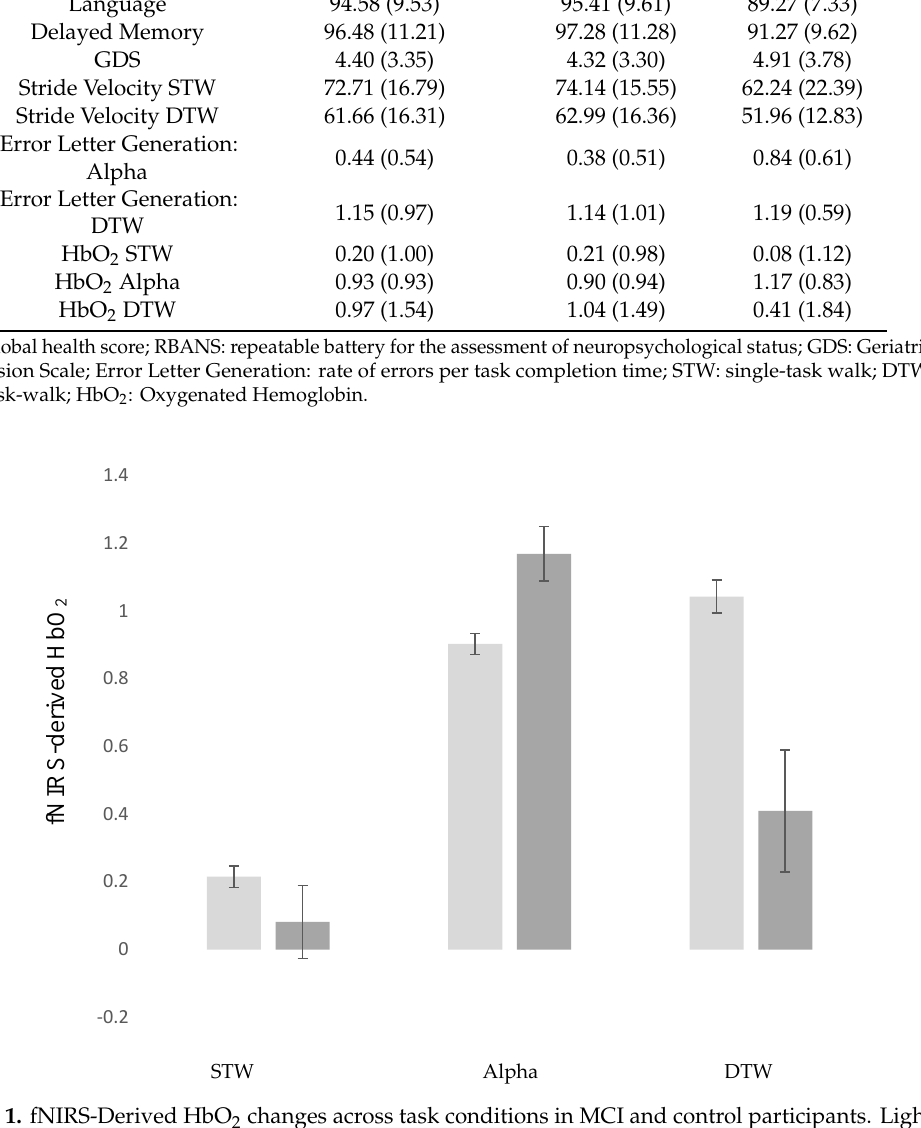
Figure 1. fNIRS-Derived HbO 2 changes across task conditions in MCI and control participants. Light Grey: Control Participants; Dark Grey: MCI Participants. STW: Single-Task-Walk; Alpha: Cognitive Interference Task; DTW: Dual-Task-Walk; MCI: Mild Cognitive Impairments.